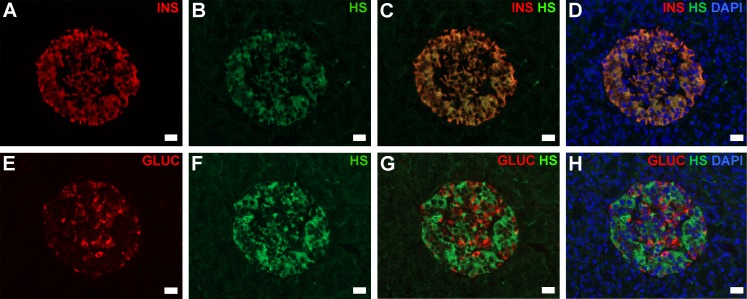
Intra-islet HS colocalizes with insulin not glucagon staining in normal human pancreas.Immunofluorescence staining of (A) insulin (INS), (B,F) HS and (E) glucagon (GLUC), in normal human pancreas (nPOD #6134). Nuclei were stained with DAPI (D,H). (A) anti-insulin Ab; (B,F) 10E4 anti-HS mAb; (E) anti-glucagon Ab; (C,G) merged (excluding DAPI); (D,H) merged (including DAPI). Scale bar = 20 μm.